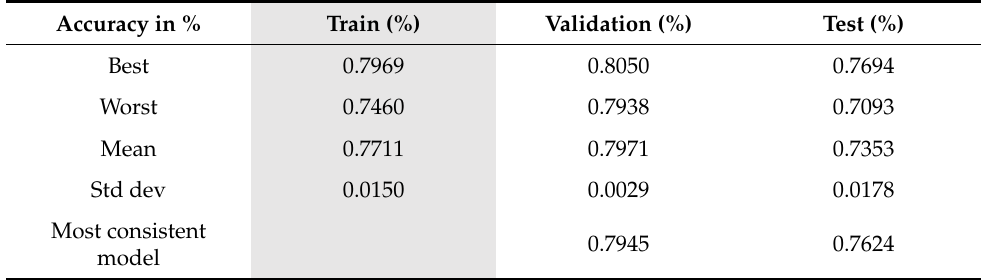
Table 2. Summary table for Approach A2—Bayesian accuracy (in %).